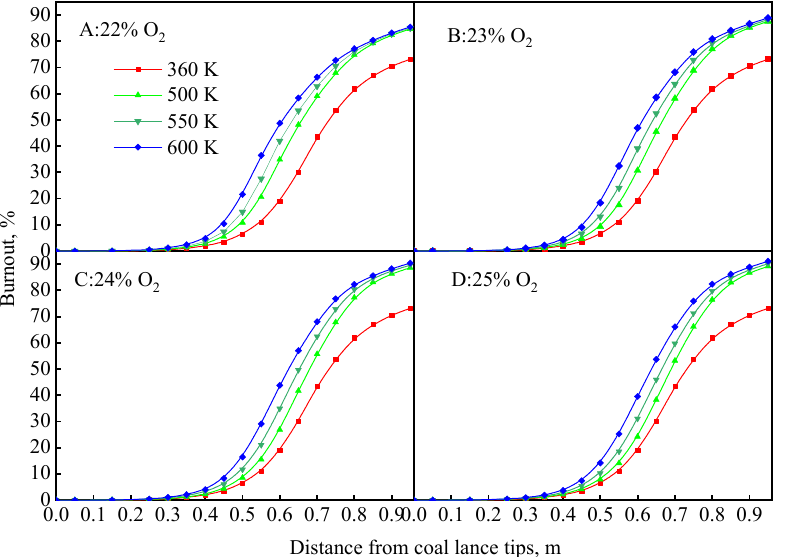
Figure 15. Coal burnout at different positions under co-enhancement of heat and